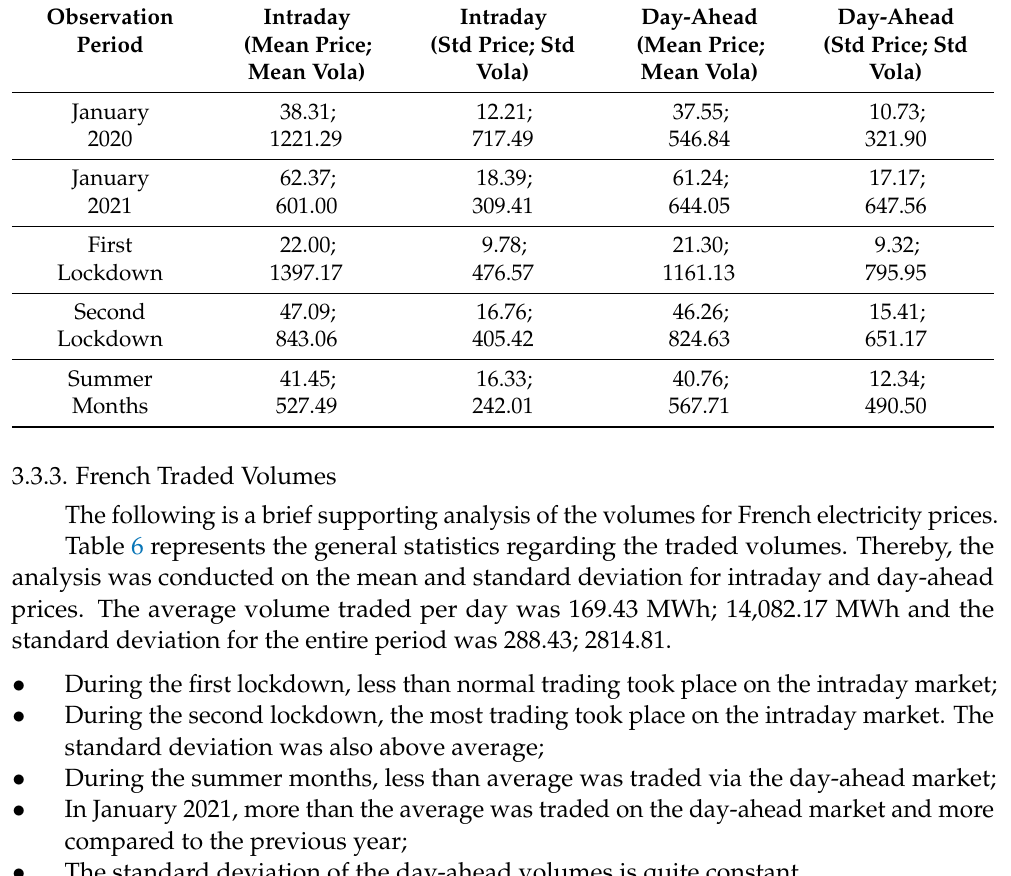
Table 6. General Statistics about French Volumes in MWh. Observation